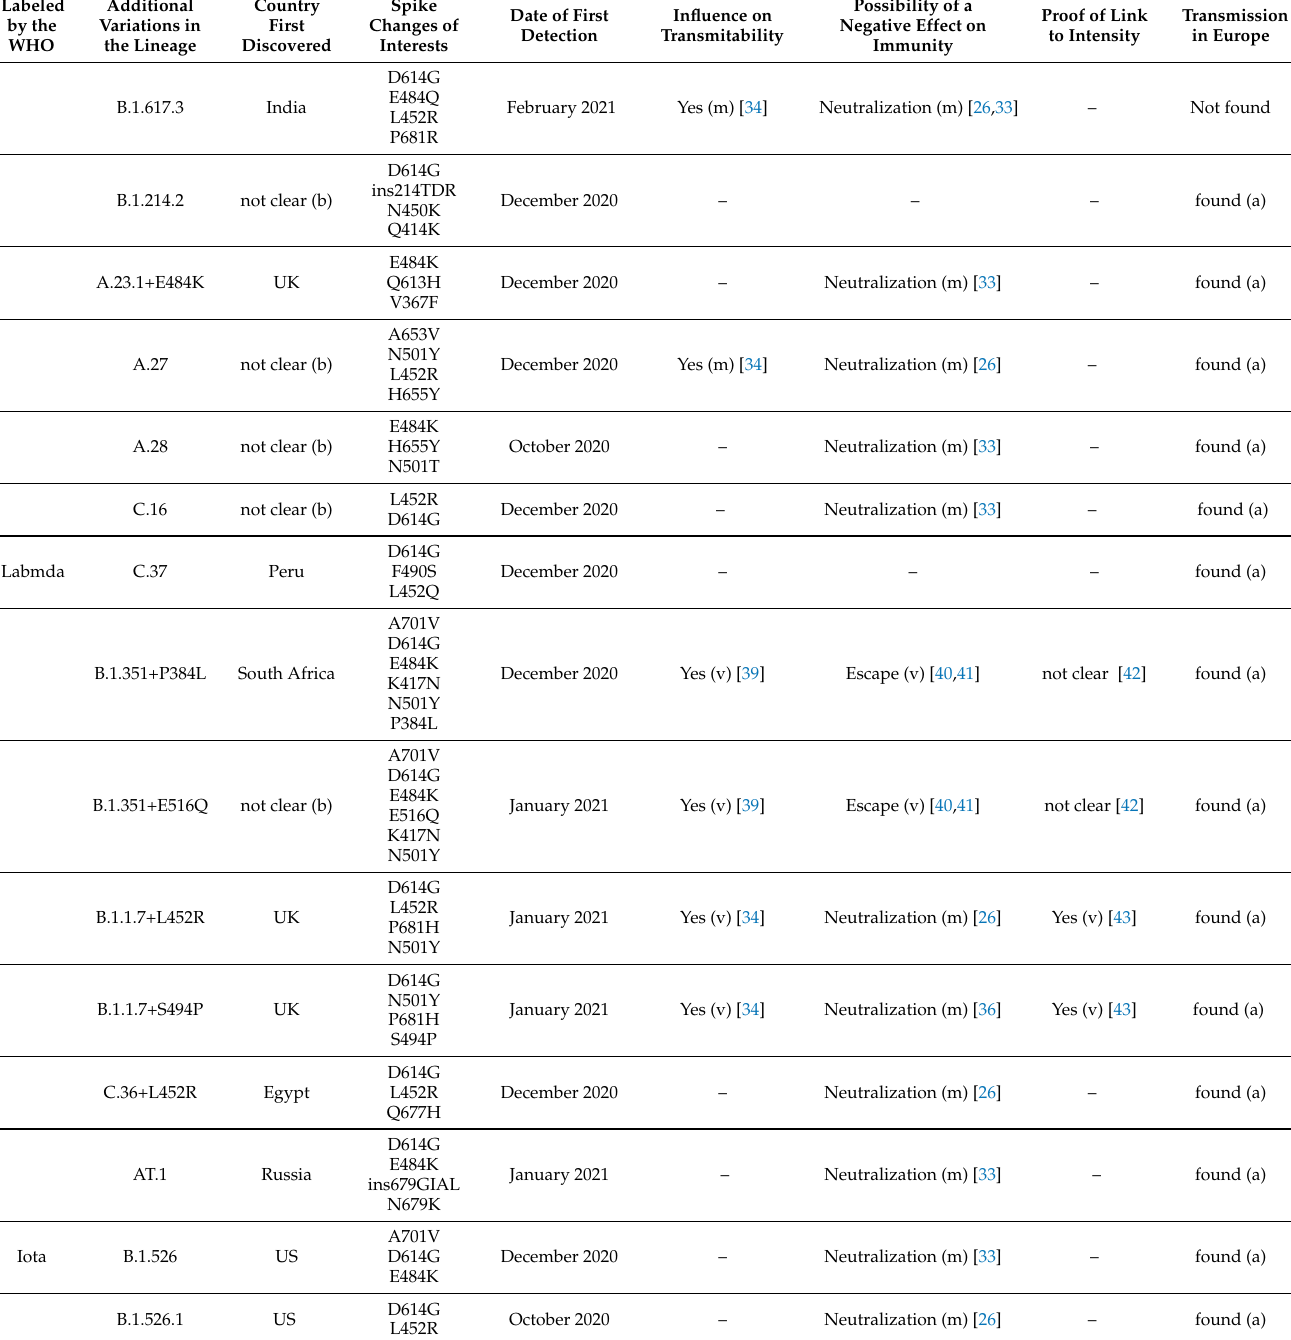
Table 3. Variants under observation